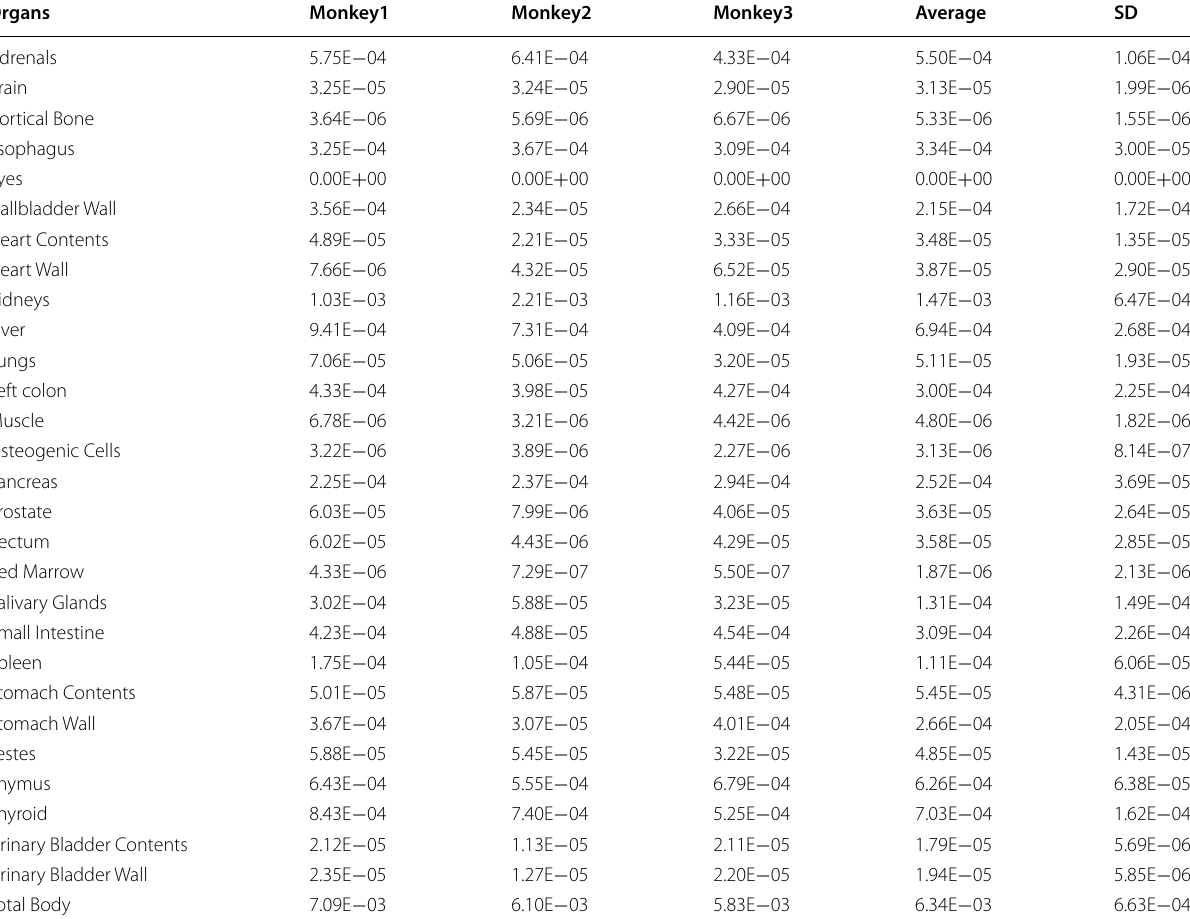
Table 1 68 Ga-NODAGA-BMS986192 Dosimetry Summary of Effective Doses in healthy male cynomolgus